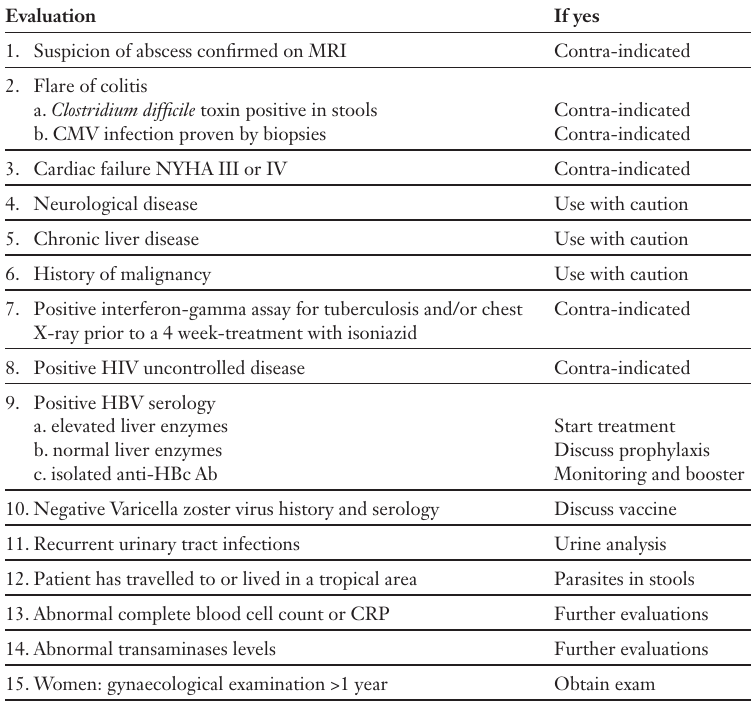
indications and contra-indications of antiTNF- α therapy with respect to findings during screening before